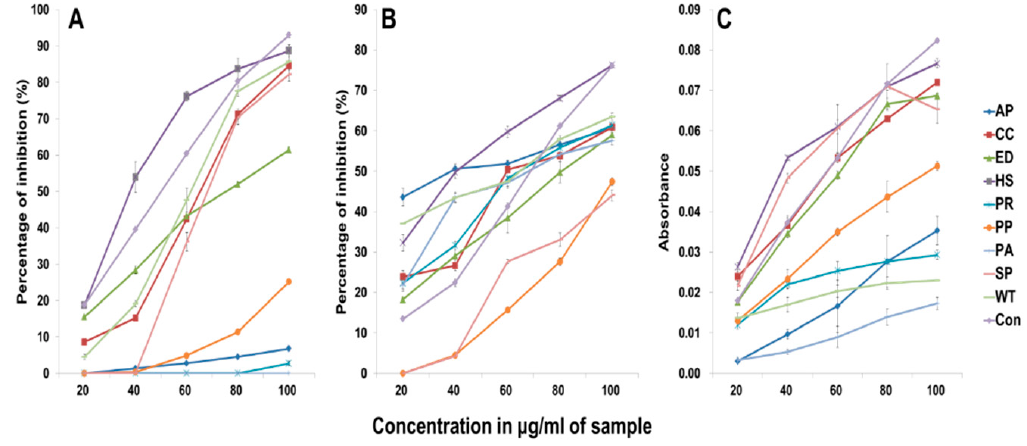
Figure 2. Antioxidant activity of different Mentha extracts. Ascorbic acid was used as the control. ( A ) 1,1-diphenyl-2-picryl-hydrazyl (DPPH) assay; ( B ) hydrogen peroxide assay; ( C ) reducing